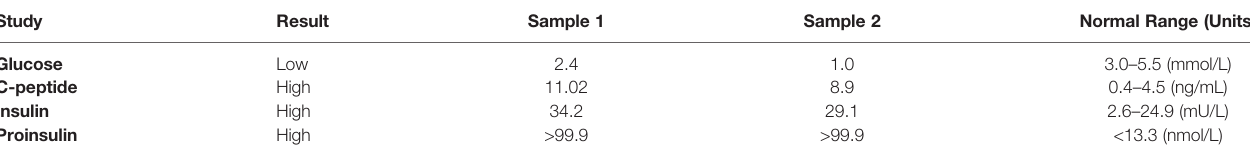
TABLE 1B | Paired glucose, C-peptide, insulin, and proinsulin concentrations during inpatient fasting episodes of hypoglycemia.